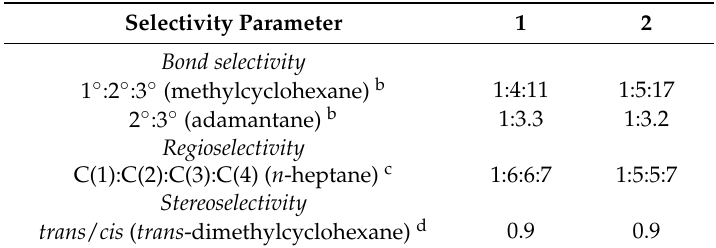
Table 1. Different selectivity parameters in the mild oxidation of methylcyclohexane, adamantine, n -heptane, and trans -dimethylcyclohexane catalyzed by 1 and 2 . a